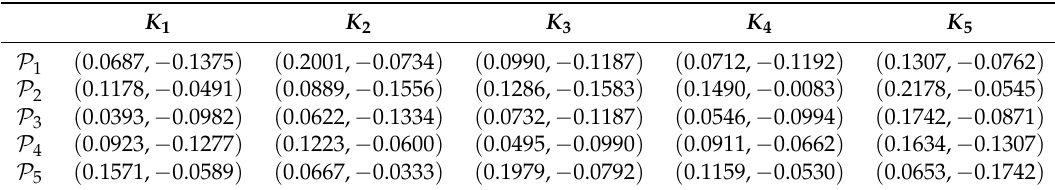
Table 9. Weighted bipolar fuzzy decision